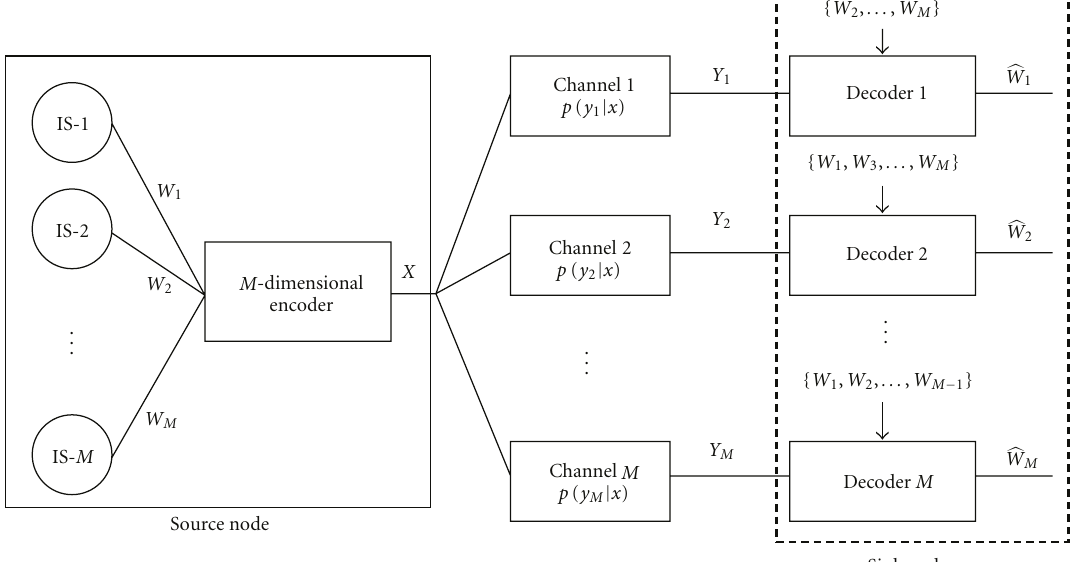
Figure 4: Equivalent scheme for adaptive transmission. M information sources { IS 1 , ... ,IS M } are located in the source node. Information source IS i produces a message addressed to sink i which has previous knowledge of messages produced by information sources in the subset p ( y x ) represents the probability transition function of the channel between the source node and sink i . S \ IS i . i |